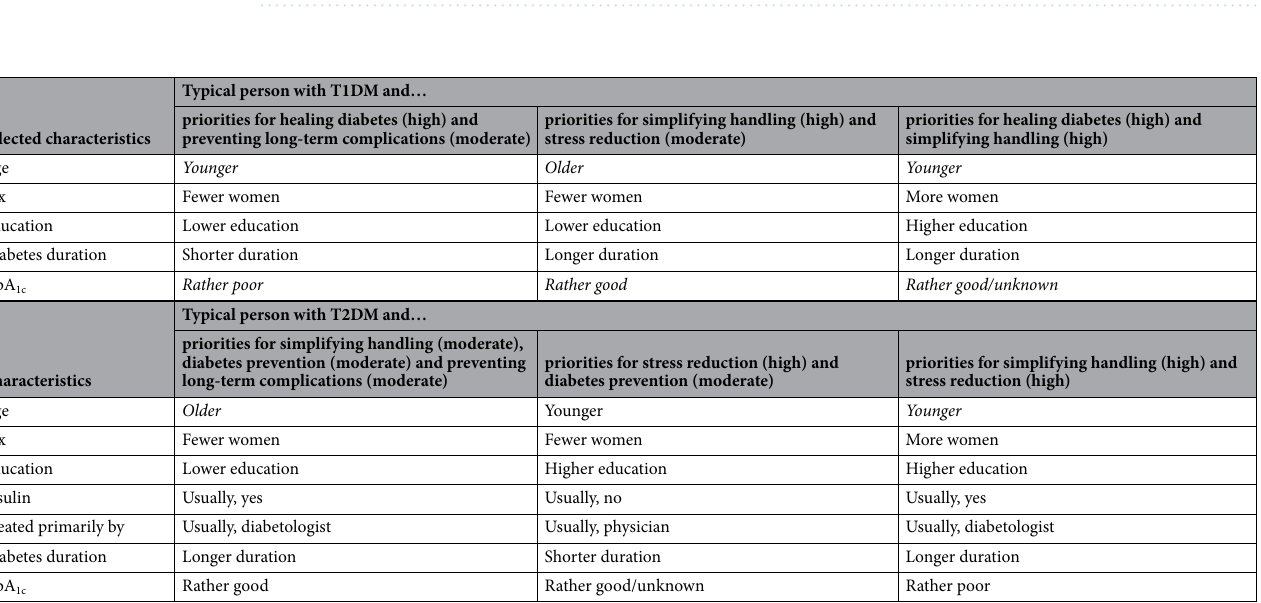
Table 2. LCA with covariates stratified by type of diabetes. OR = odds ratio (corresponding to one unit change in age and diabetes duration). CI = confidence interval. At level 5% significant results are in bold.